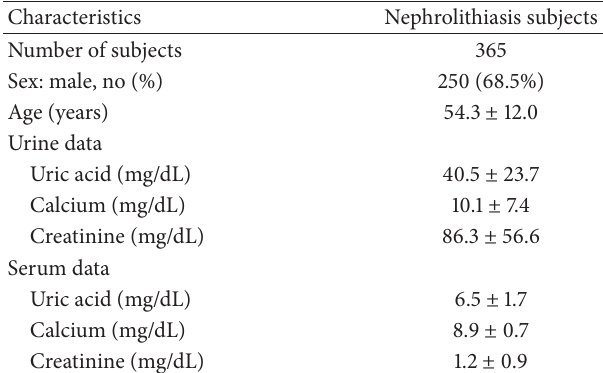
Table 1: Basic characteristics of patients with